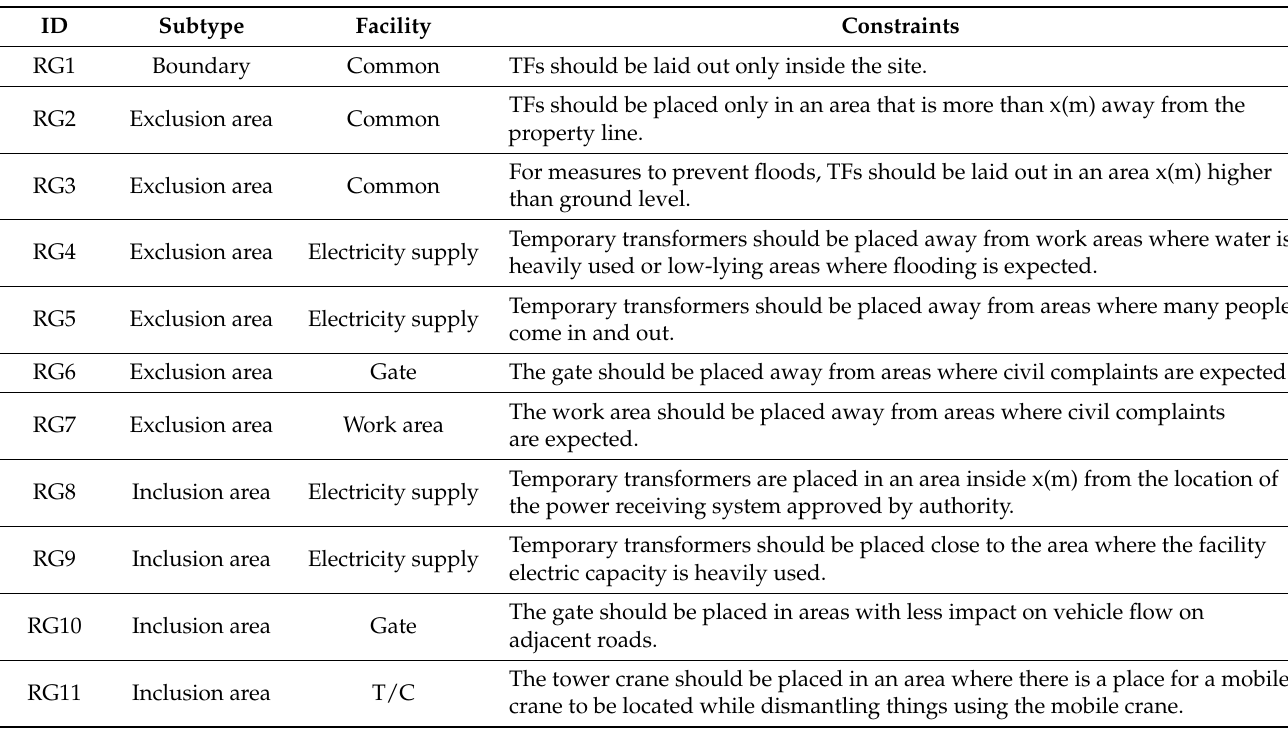
Table 4. Regional type constraints identified in this study.